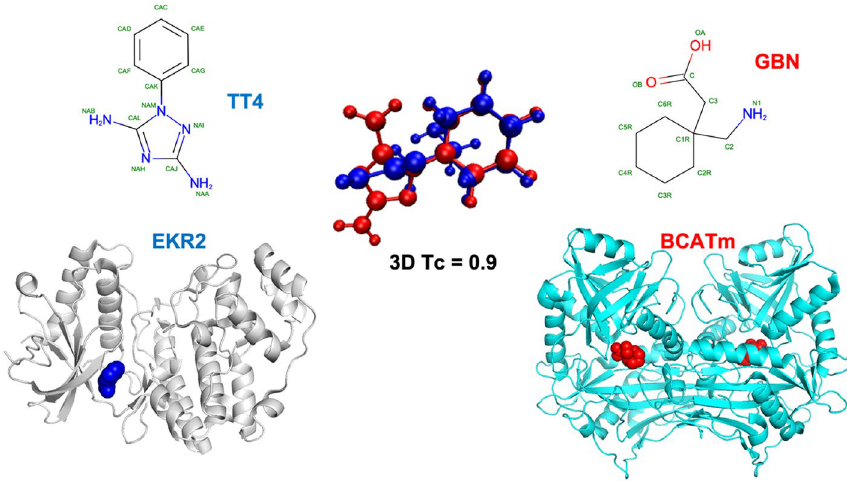
Figure 3. The 3D similarity of TT4 and GBN is evident. However, 2D similarity is low and their binding sites show no similarity as